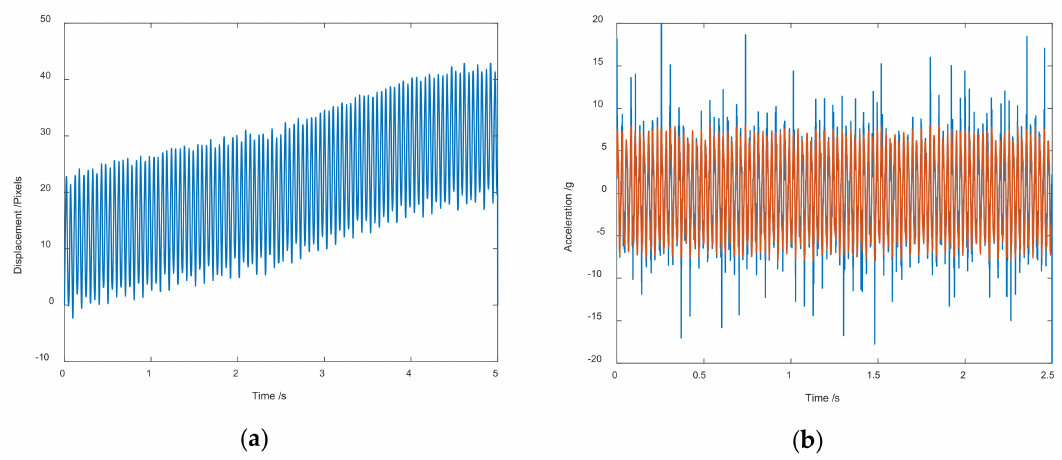
Figure 4. Results of post-processing: ( a ) Cumulative displacement of object motion calculated by Viaxl; ( b ) comparison of acceleration calculation with and without